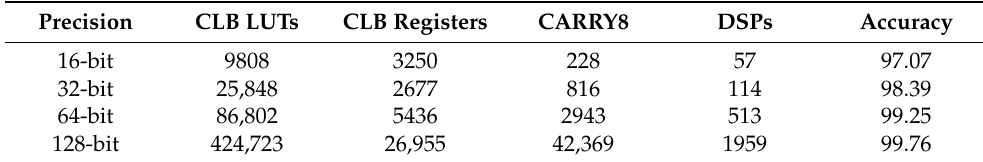
Table 2. Resource utilization of different precision designs.